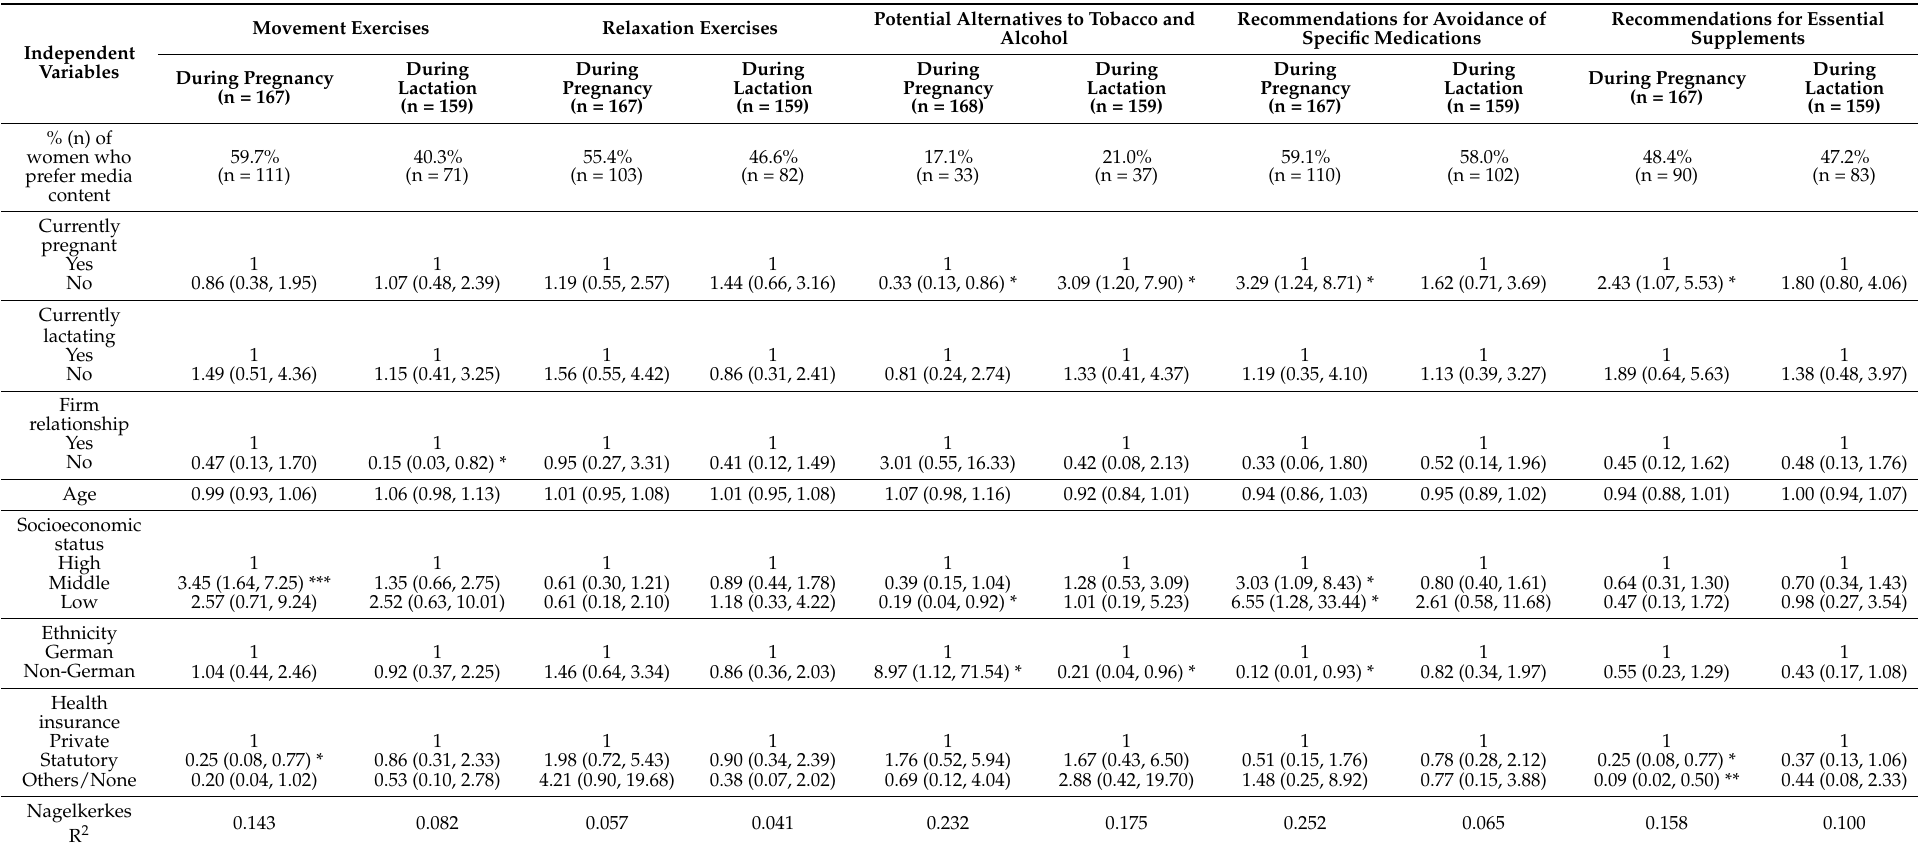
Table 5. Women’s preferred media content during pregnancy and lactation in association with independent variables, expressed in odds ratios (95% confidence intervals).